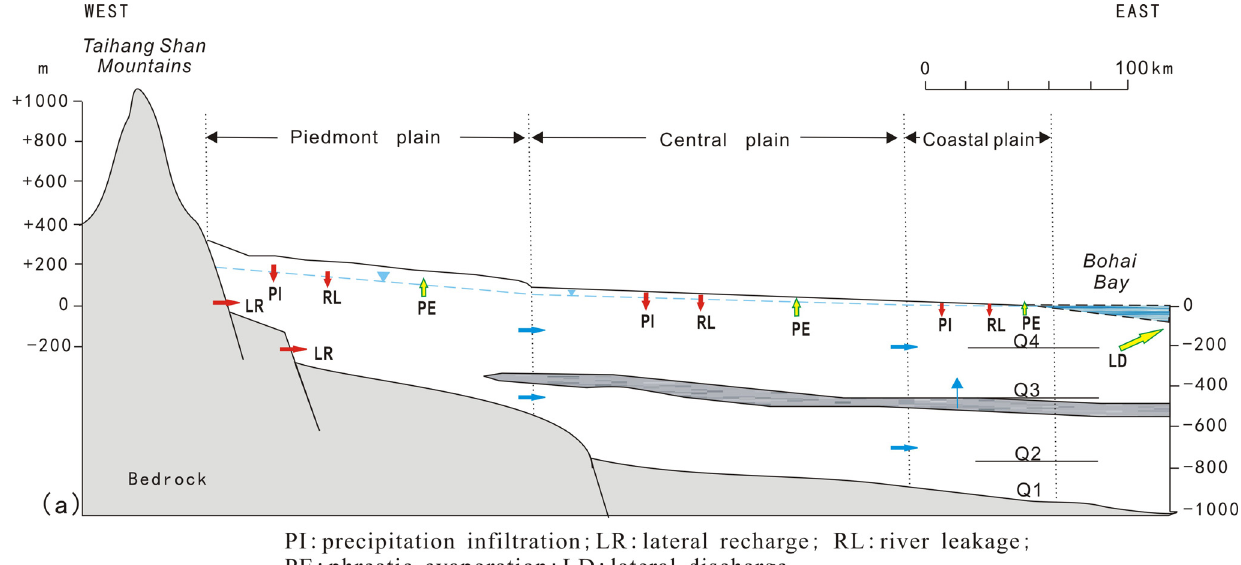
Figure 3. Changes in groundwater recharge, runoff, and discharge in the study area ( a ) in the natural state; and ( b ) under natural climate and anthropogenic